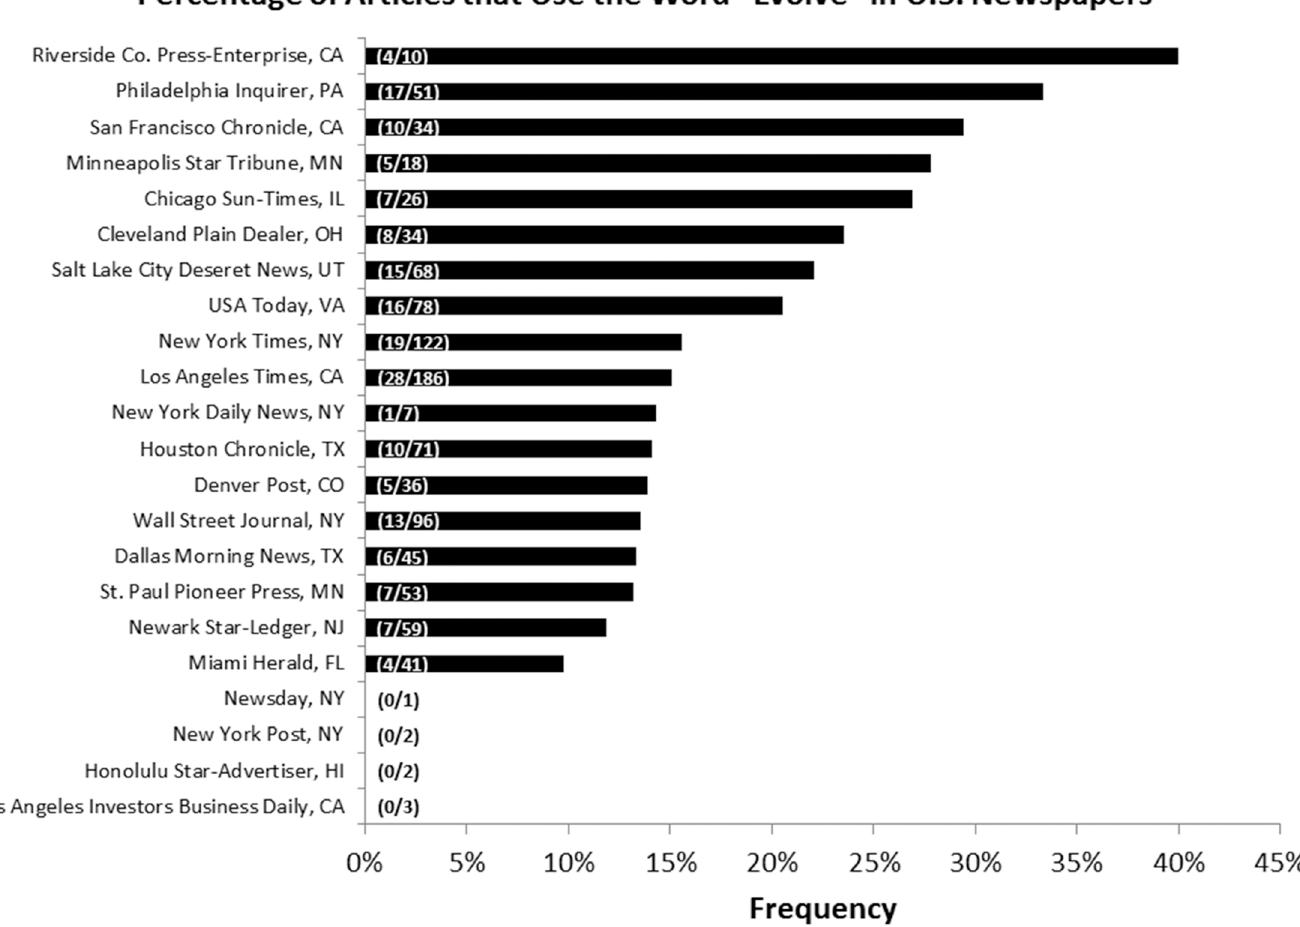
PLOS ONE | DOI:10.1371/journal.pone.0150396 March 2,